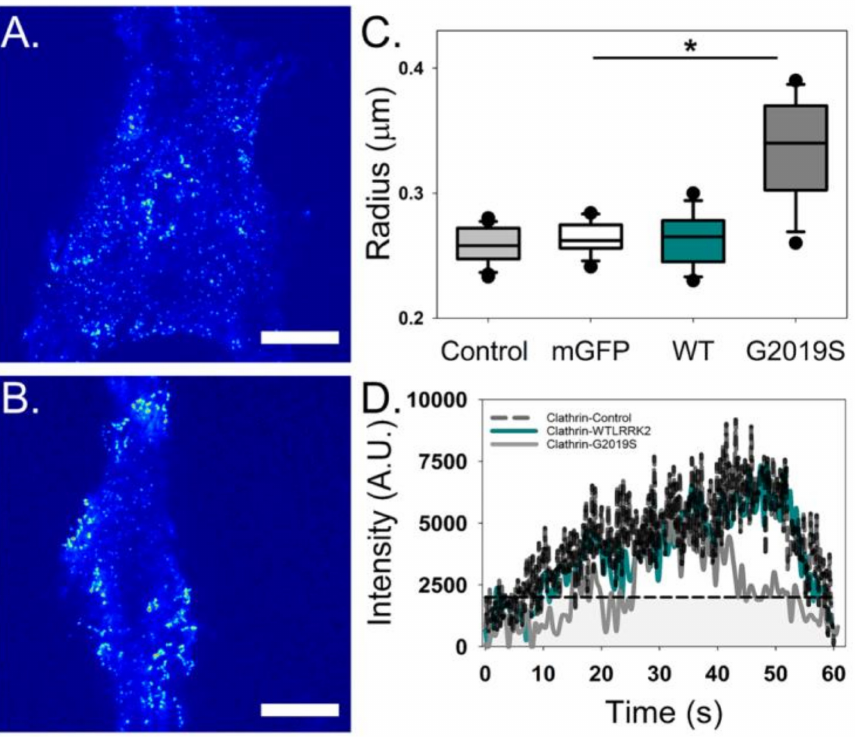
Figure 5. Clathrin puncta on the plasma membrane are altered when co-transfected with G2019S. Total internal reflection fluorescence (TIRF) microscopy intensity images of clathrin puncta co-expressed with either WT LRRK2-GFP ( A ) or G2019S LRRK2-GFP ( B ). ( C ) Clathrin expressed with G2019S shows a significant increase in the radius of endocytic spots when compared to controls and WT ( p < 0.05, n ≥ 40 cells). ( D ) A representative intensity fluctuation of a single clathrin puncta plotted as a function of time over a 60 s period for the clathrin control (black), WT LRRK2-GFP (dark cyan) and G2019S LRRK2-GFP